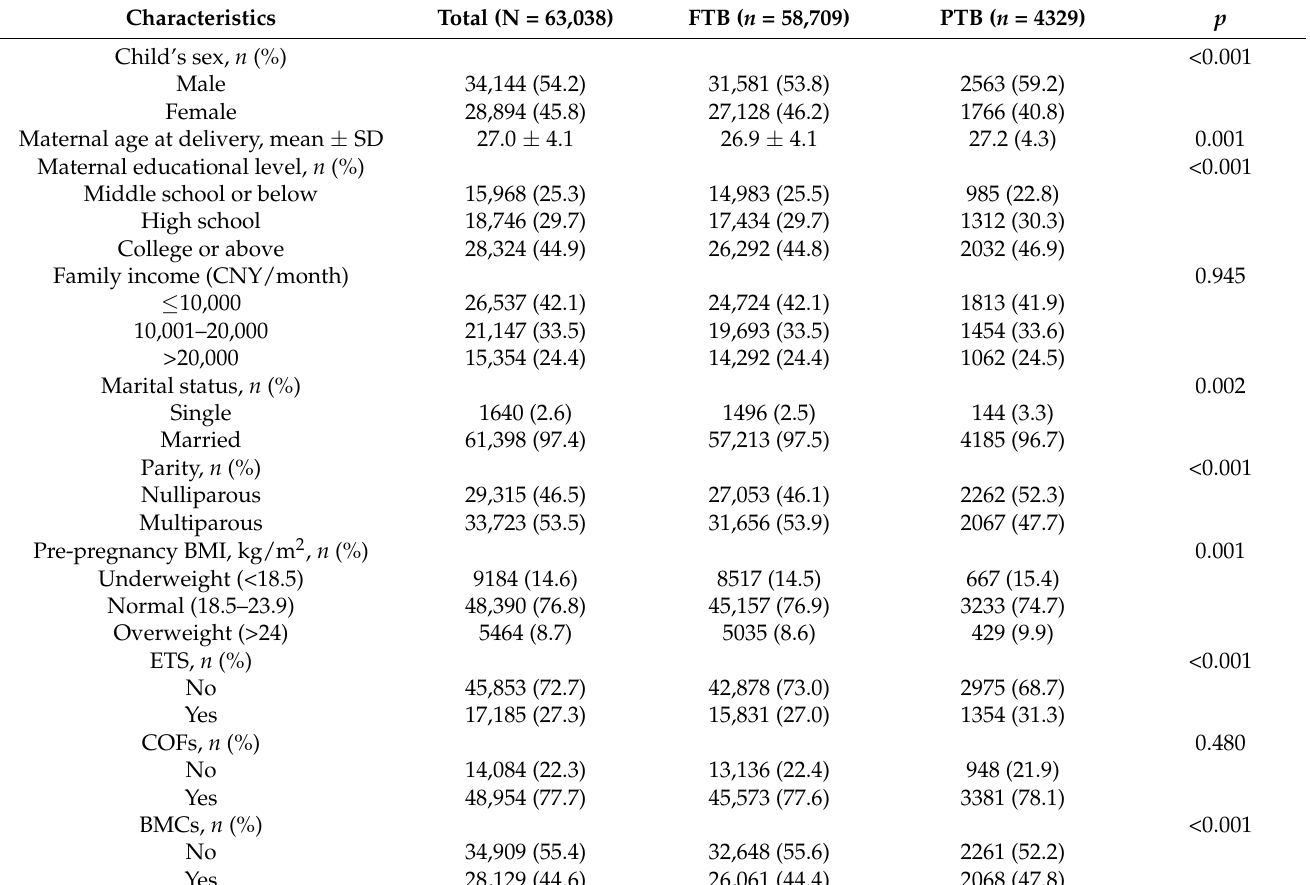
Table 2. Characteristics of the study population and comparison of PTB and FTB